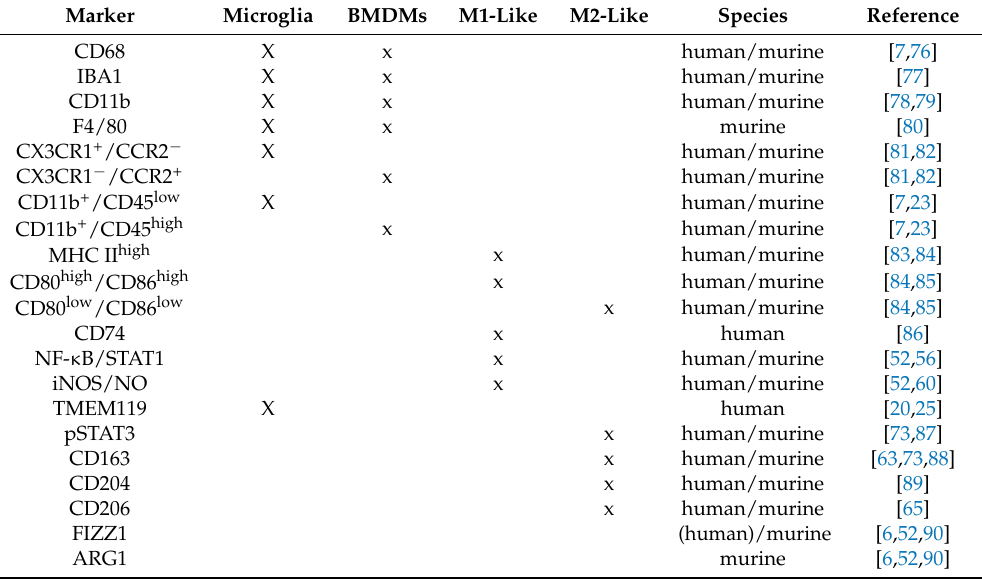
Table 1. Glioma-associated microglia/macrophage